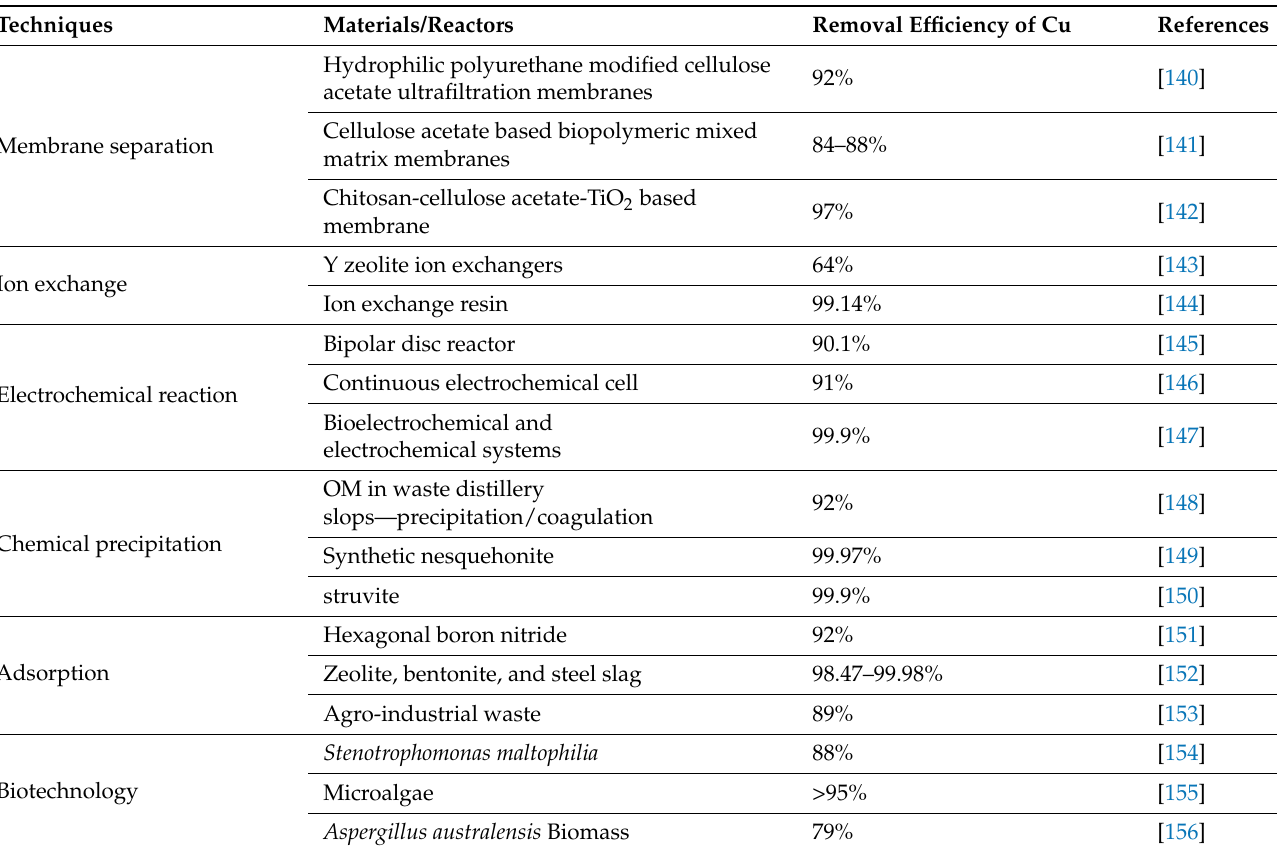
Table 2. Summary of copper removal efficiency based on different treatments.